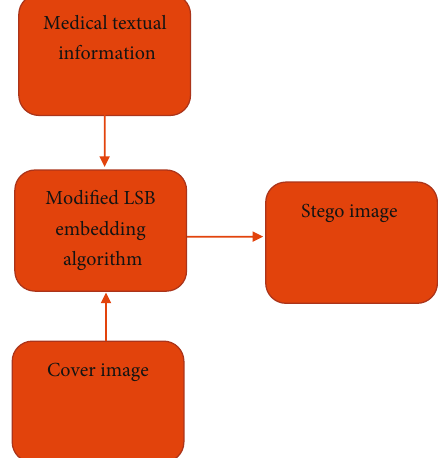
Figure 1: Embedding phase of the projected